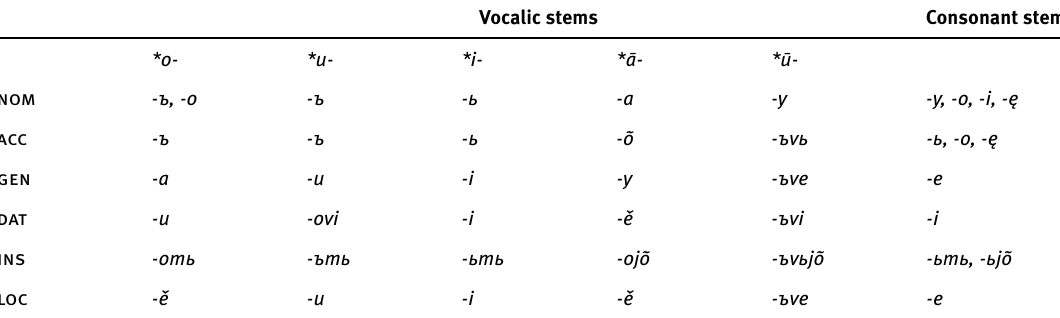
Table 2. Late Proto-Slavic inflectional classes (singular